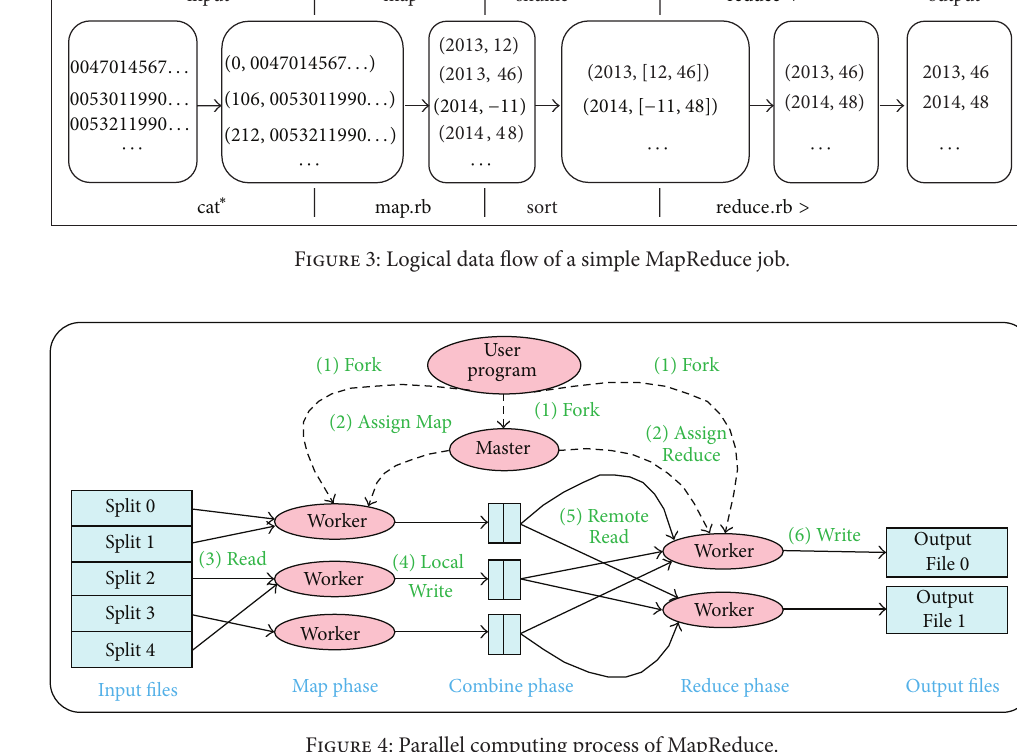
Figure 4: Parallel computing process of MapReduce.